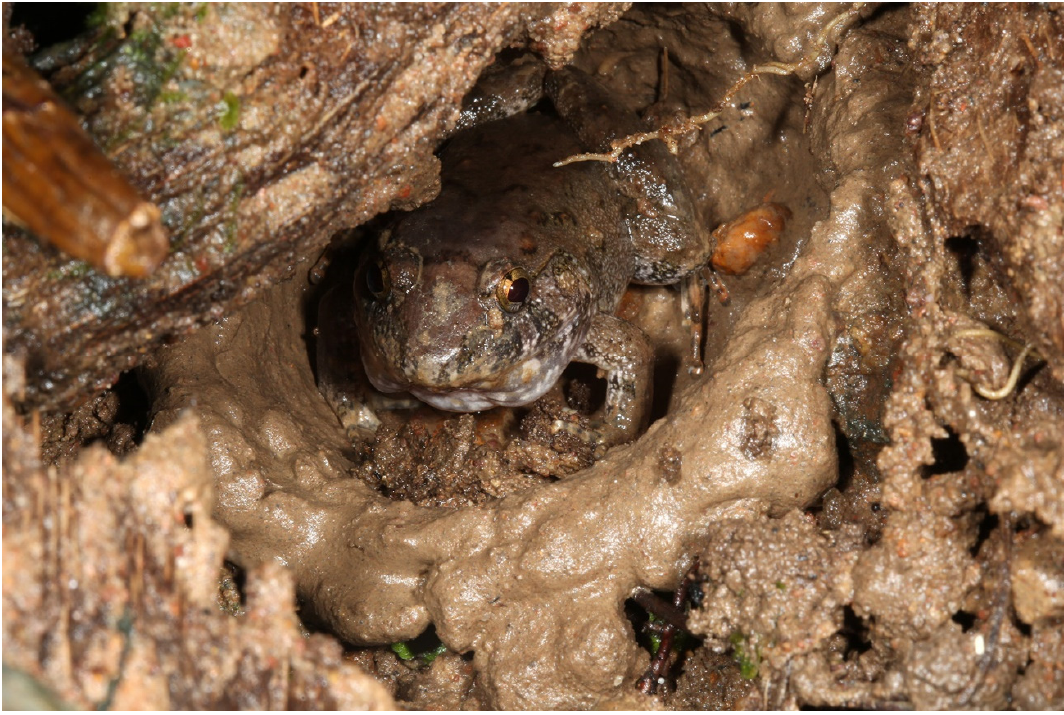
Figure 11. Holotype of Limnonectes bagoensis n. sp. ( SMF 104090) in life, at its calling site after the covering rocks had been removed.